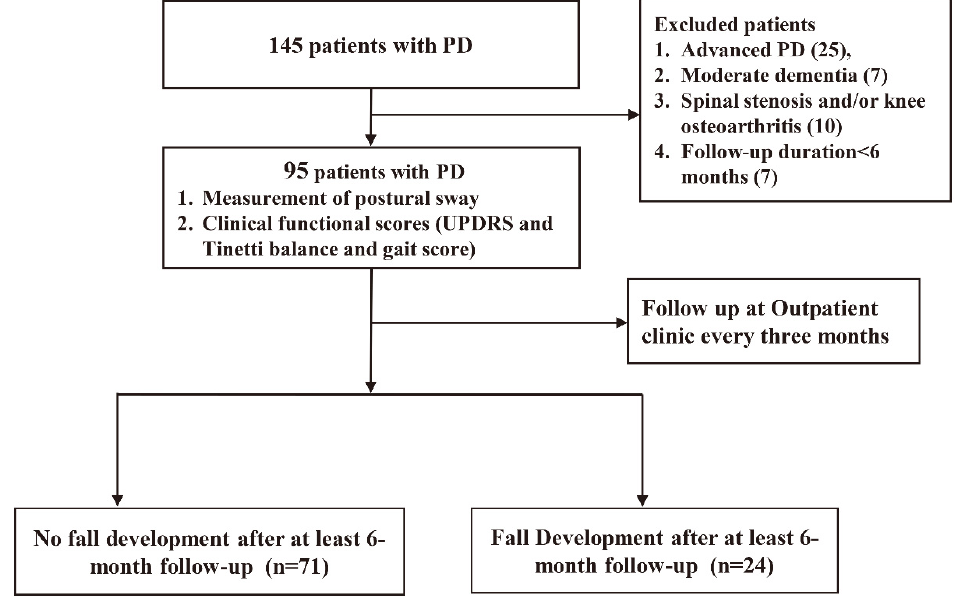
Figure 1. Enrollment of